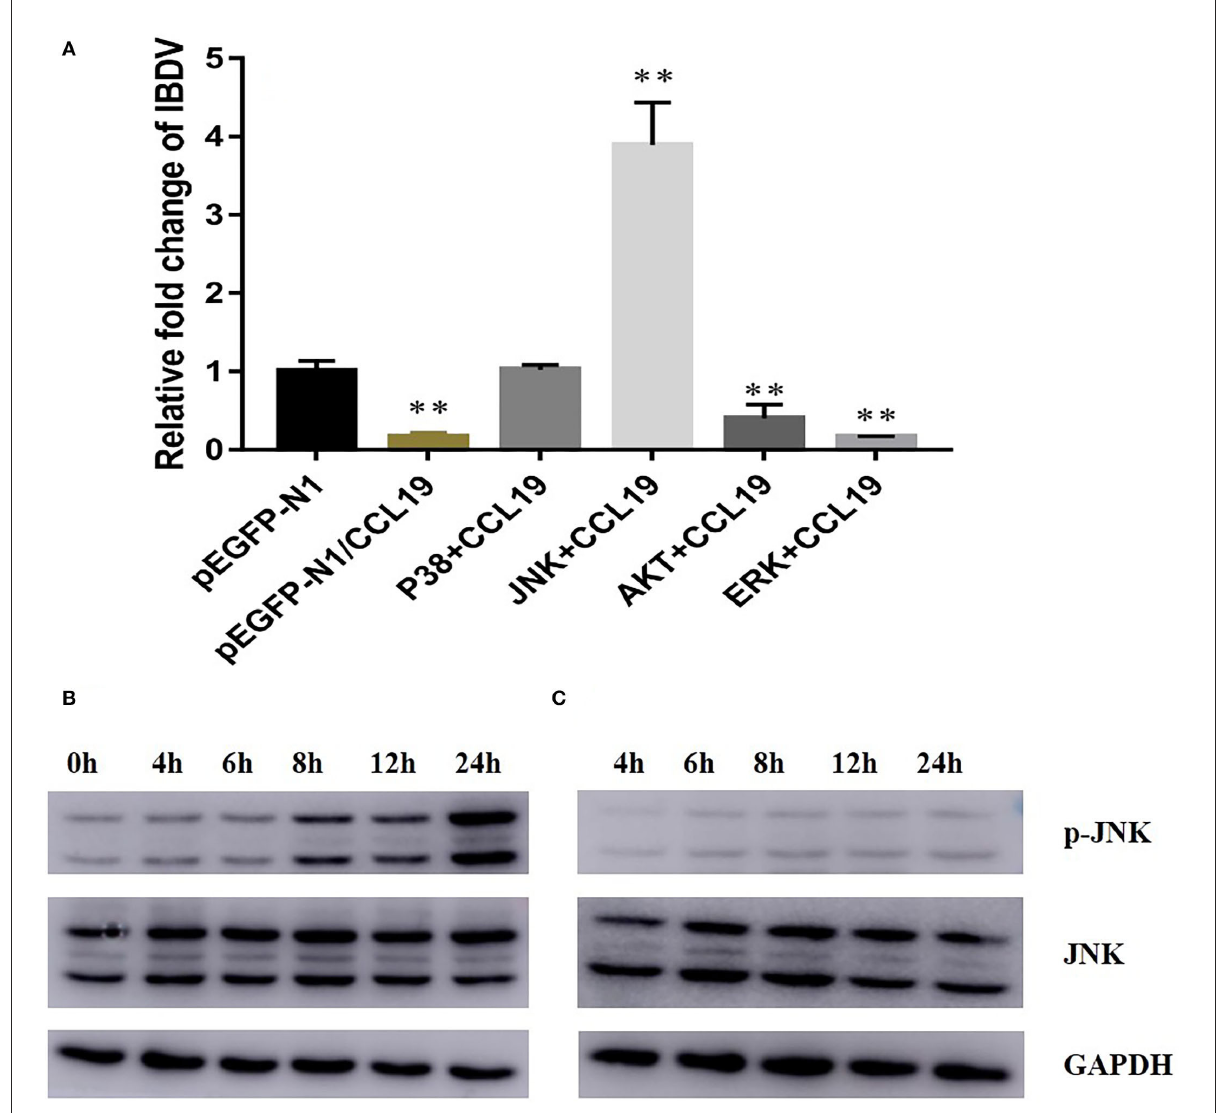
FIGURE5 CCL19 activates JNK signal pathway to inhibit IBDV replication. (A) DF1 cells were pretreated with 20 µ M of four signal pathway inhibitors before transfection with pEGFP-N1/CCL19 plasmid and then infected with IBDV. At 48h post-infection with IBDV, DF1 cells were collected for determination of IBDV VP2 gene expression levels. DF1 cells were transfected with either pEGFP-N1/CCL19 and sampled at 0, 4, 6, 8, 12, and 24h post-transfection (B) or pEGFP-N1 control plasmid and sampled at 4, 6, 8, 12, and 24h post-transfection (C) ; then, p-JNK, JNK, and GAPDH expression were determined by western blotting. ** Indicates significant differences of relative fold changes on IBDV between pEGFP-N1 and other groups ( p <